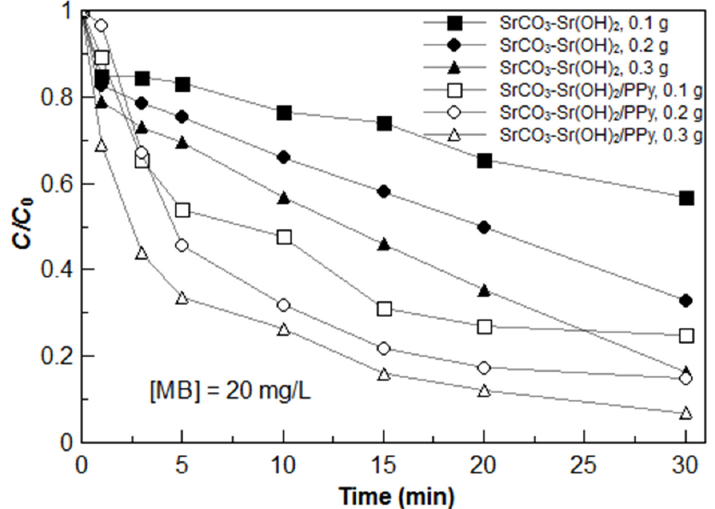
Figure 8. MB dye photodegradation kinetics under visible light irradiation using 20 mg/L of MB initial concentration and different SrCO 3 ‐ Sr(OH) 2 and SrCO 3 ‐ Sr(OH) 2 /PPy nanocomposites loading.